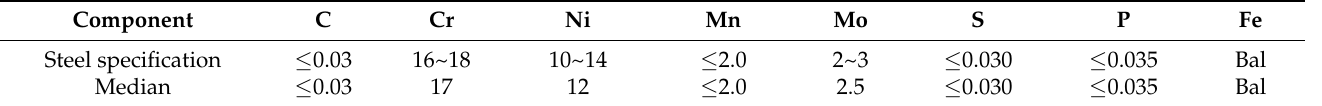
Table 1. Chemical composition of 316 stainless steel, wt